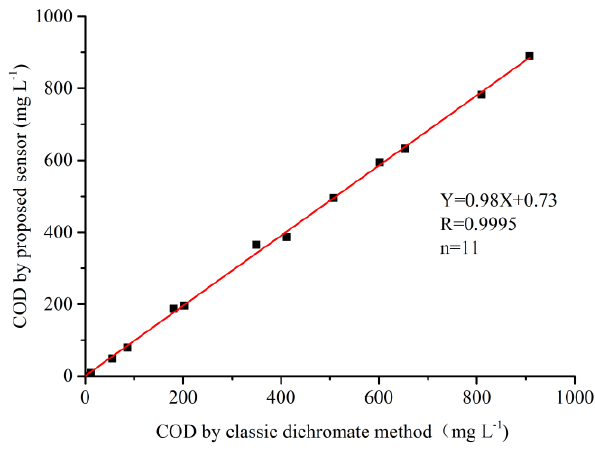
Figure 9. The relation between the COD values of synthetic samples (organic mixture) determined by the CuO/CuNWE-based electrochemical method and the classic dichromate method.